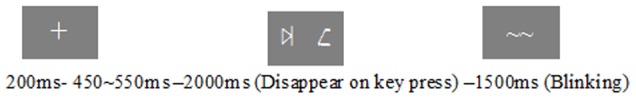
Task design of the test unit.